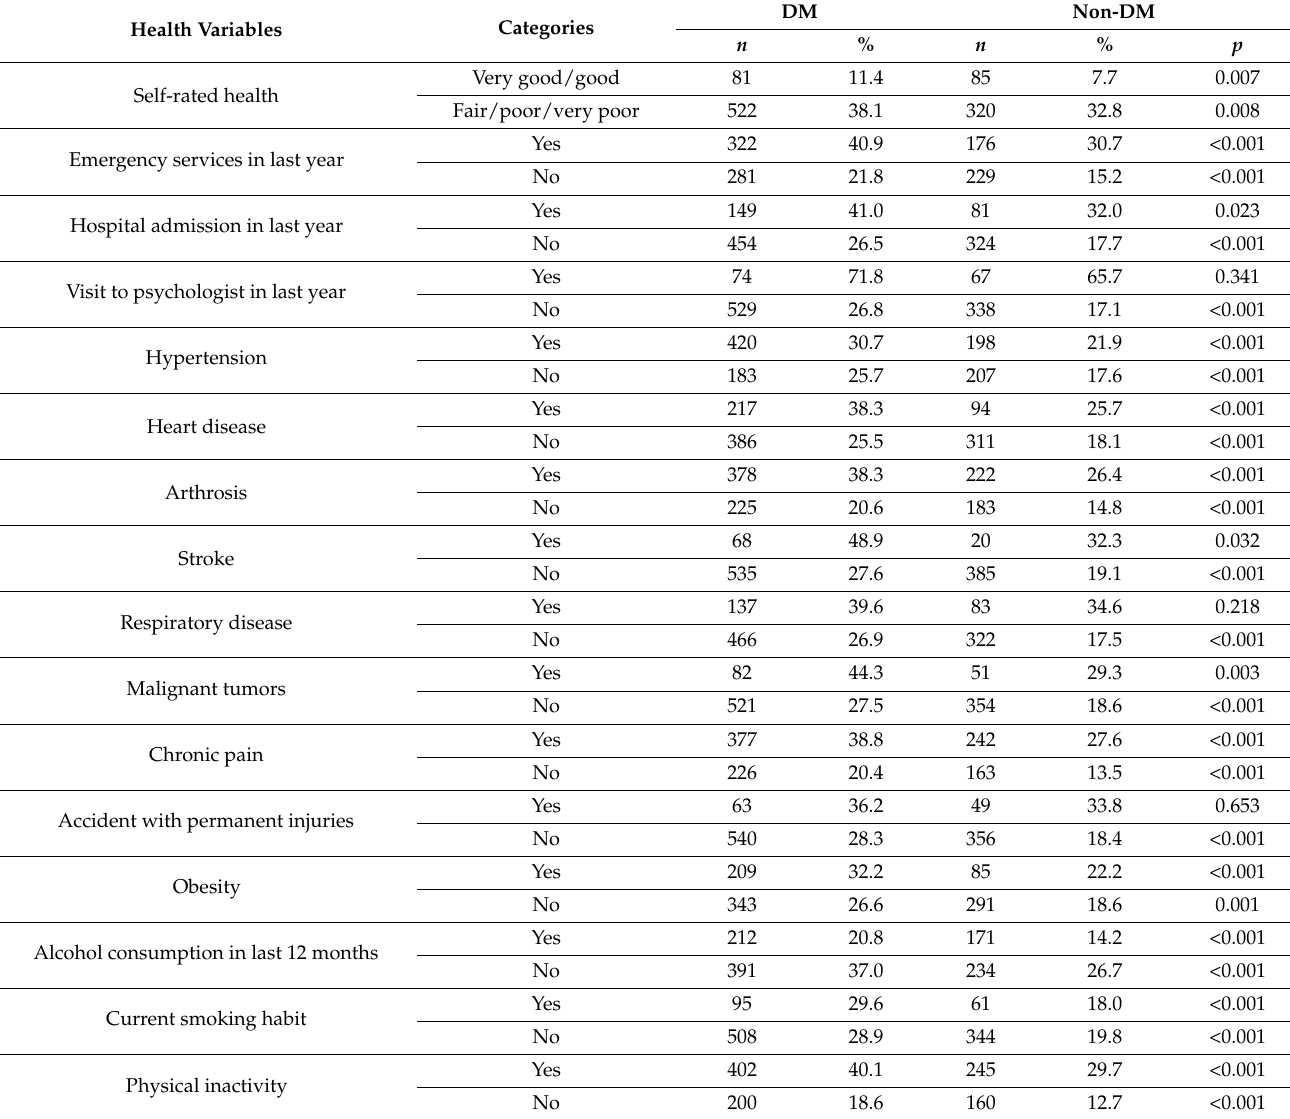
Table 2. Prevalence Psychological distress (GHQ-12 ≥ 3), according to health variables among subjects with DM and matched non-DM controls. (Spanish National Health Interview Survey, 2017). Health Variables